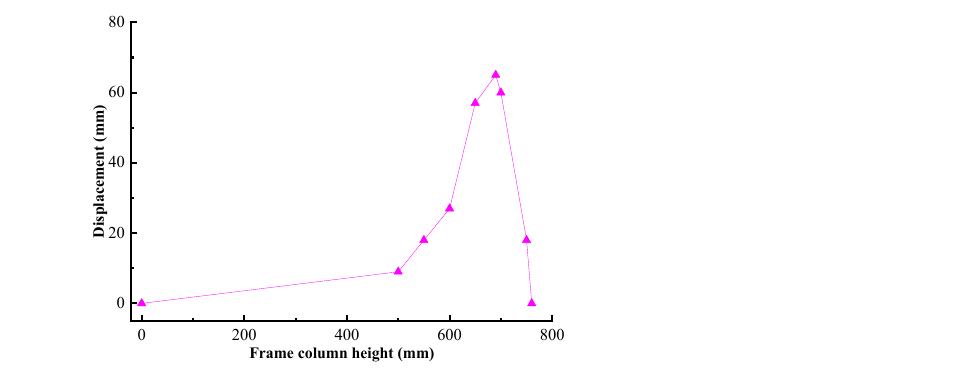
Figure 34. Out-of-plane deformation of the column flange along the height in specimen 2.